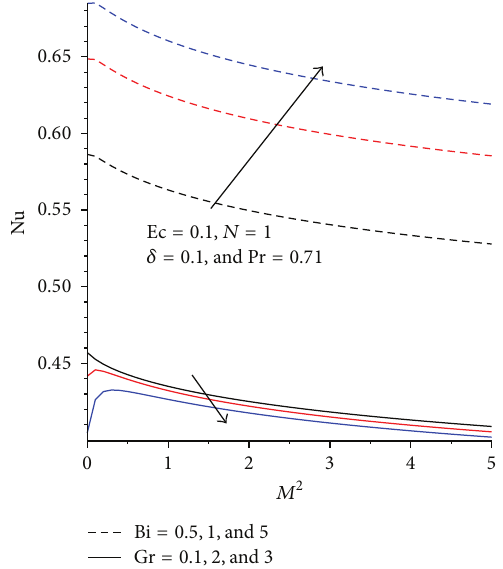
Figure 22: The Nusselt number with increasing 𝑀 , Bi, and